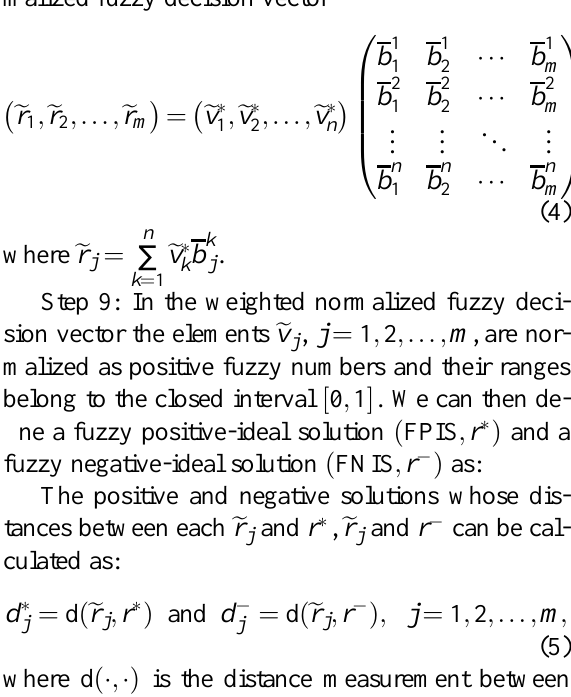
Table 2. Linguistic terms for the comparison of criteria Linguistic terms